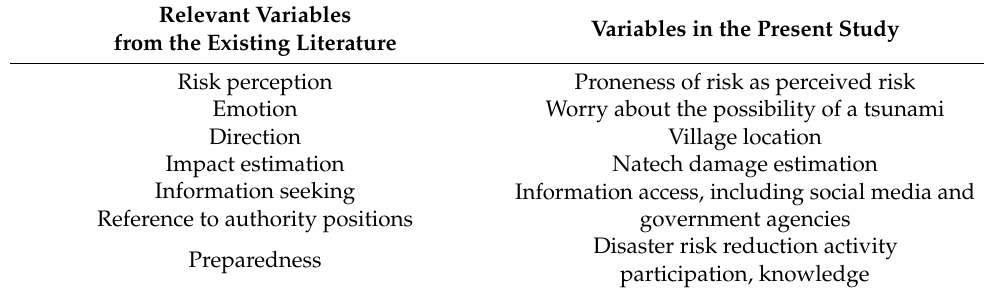
Table 1. Classification of variables influencing